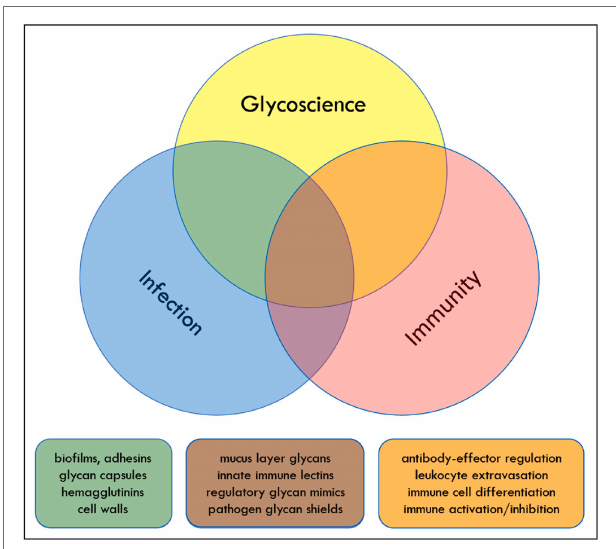
FIGURE 1 | Glycoscience, infection, and immunity overlap in multiple areas that drive pathogen and host function. Color-coded overlap topics mentioned in the text are listed as